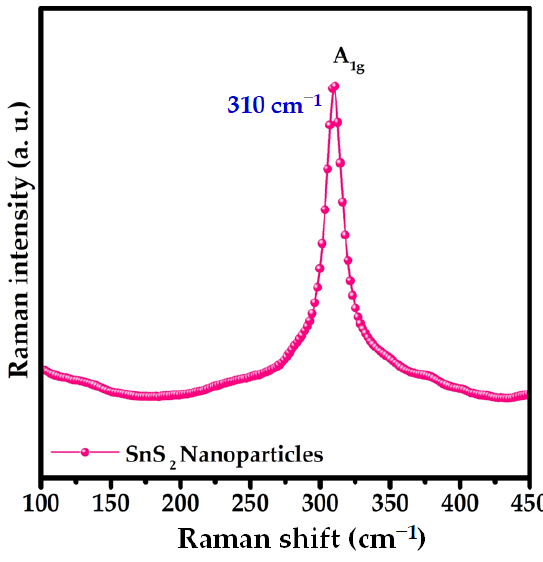
Figure 3. Raman spectrum of SnS 2